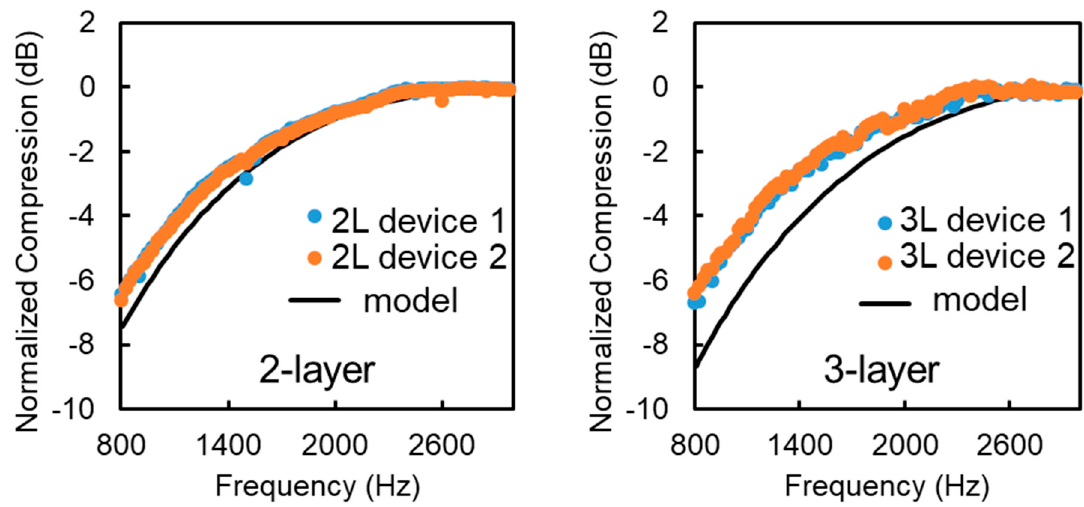
Figure 6. Graph of normalized compression of 2 ( left ) and 3 ( right ) layer artificial Pacinian Corpuscles in the range of 800–3000 Hz. The black line represents the expected compression from the model while the different colored dots represent different corpuscles with the same number of